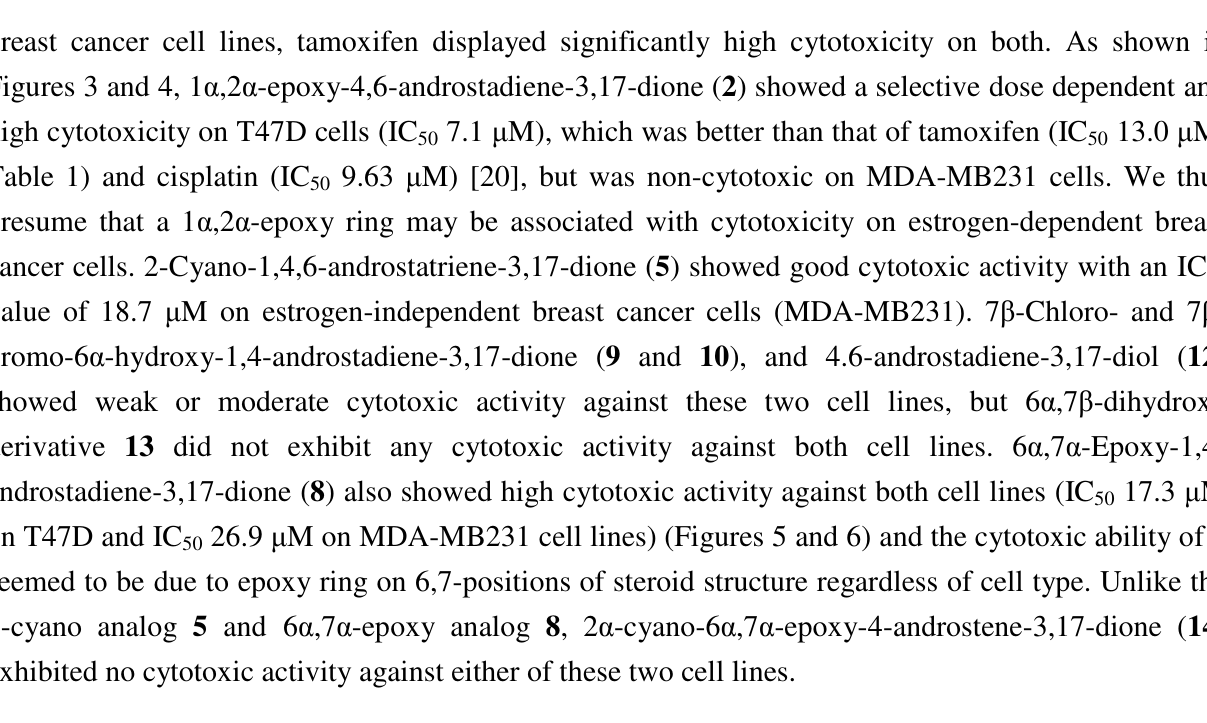
Table 1. The IC values of the synthesized compounds on T47D and MDA-MB231cell lines. 50 Compound